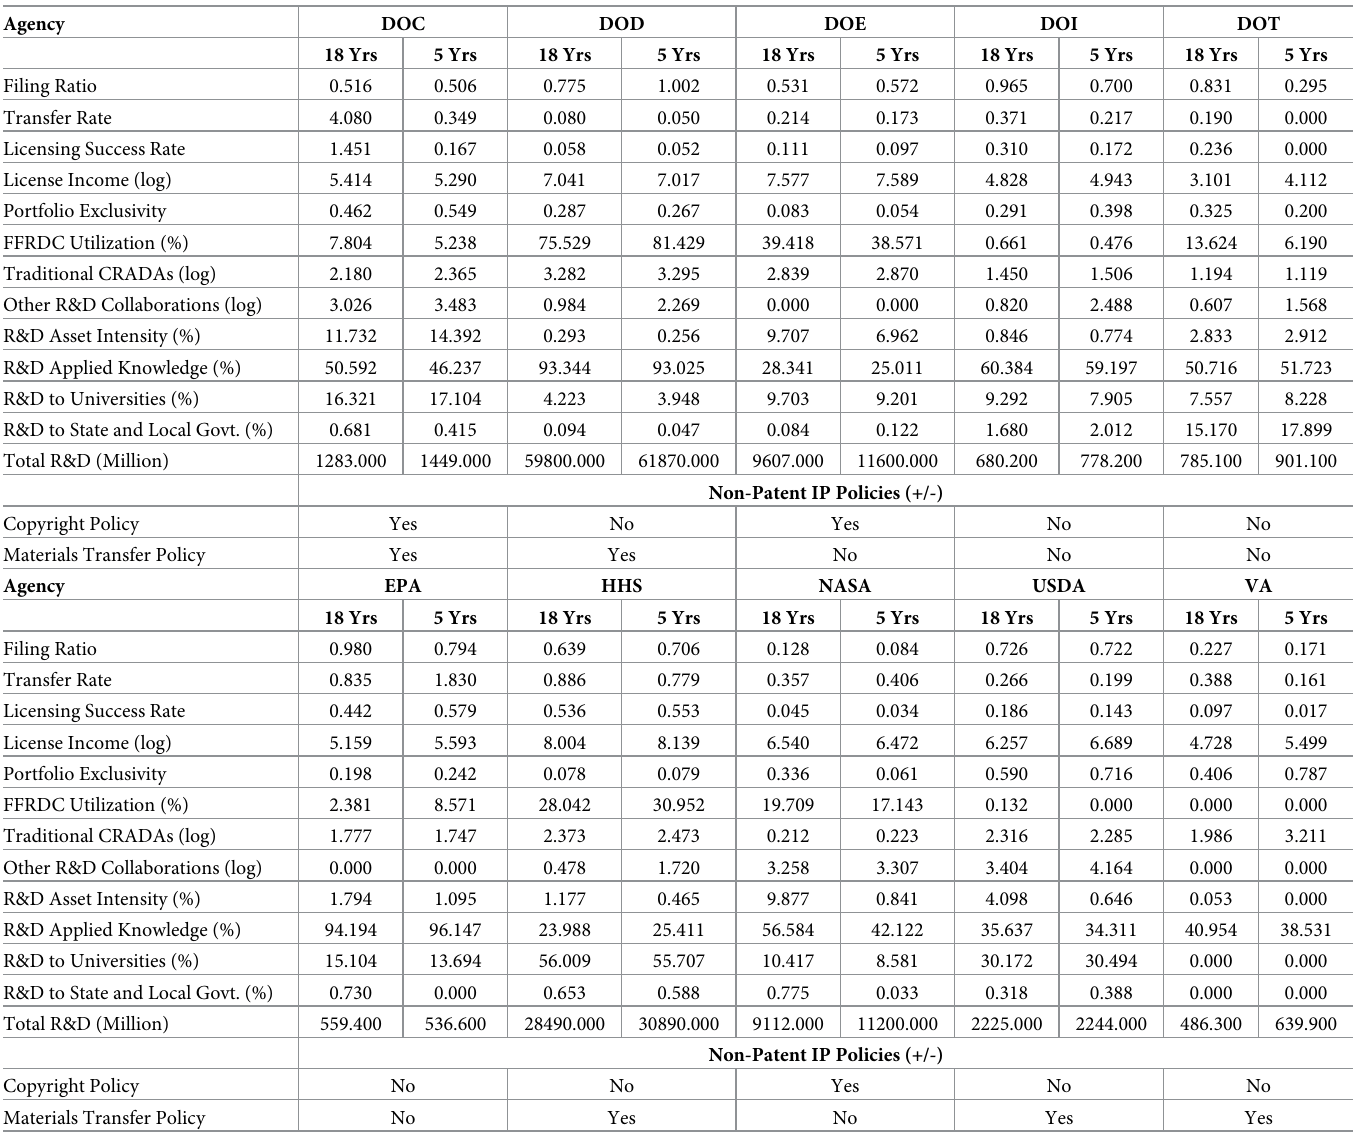
Table 3. Data summary of